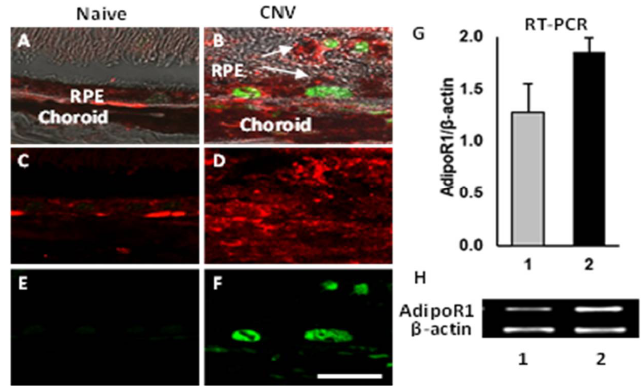
Figure 2. Expression of AdipoR1 and PCNA in RPE cells. Paraffin sections were stained using Ab against AdipoR1 and PCNA double IHC. Merged images of AdipoR1 (red color), PCNA (green color), and DIC (black and white) show colocalization of both markers and structures of the RPE- choroid complex (A,B). Red channel (C,D) and green channel (E,F) are shown separately. Panel G